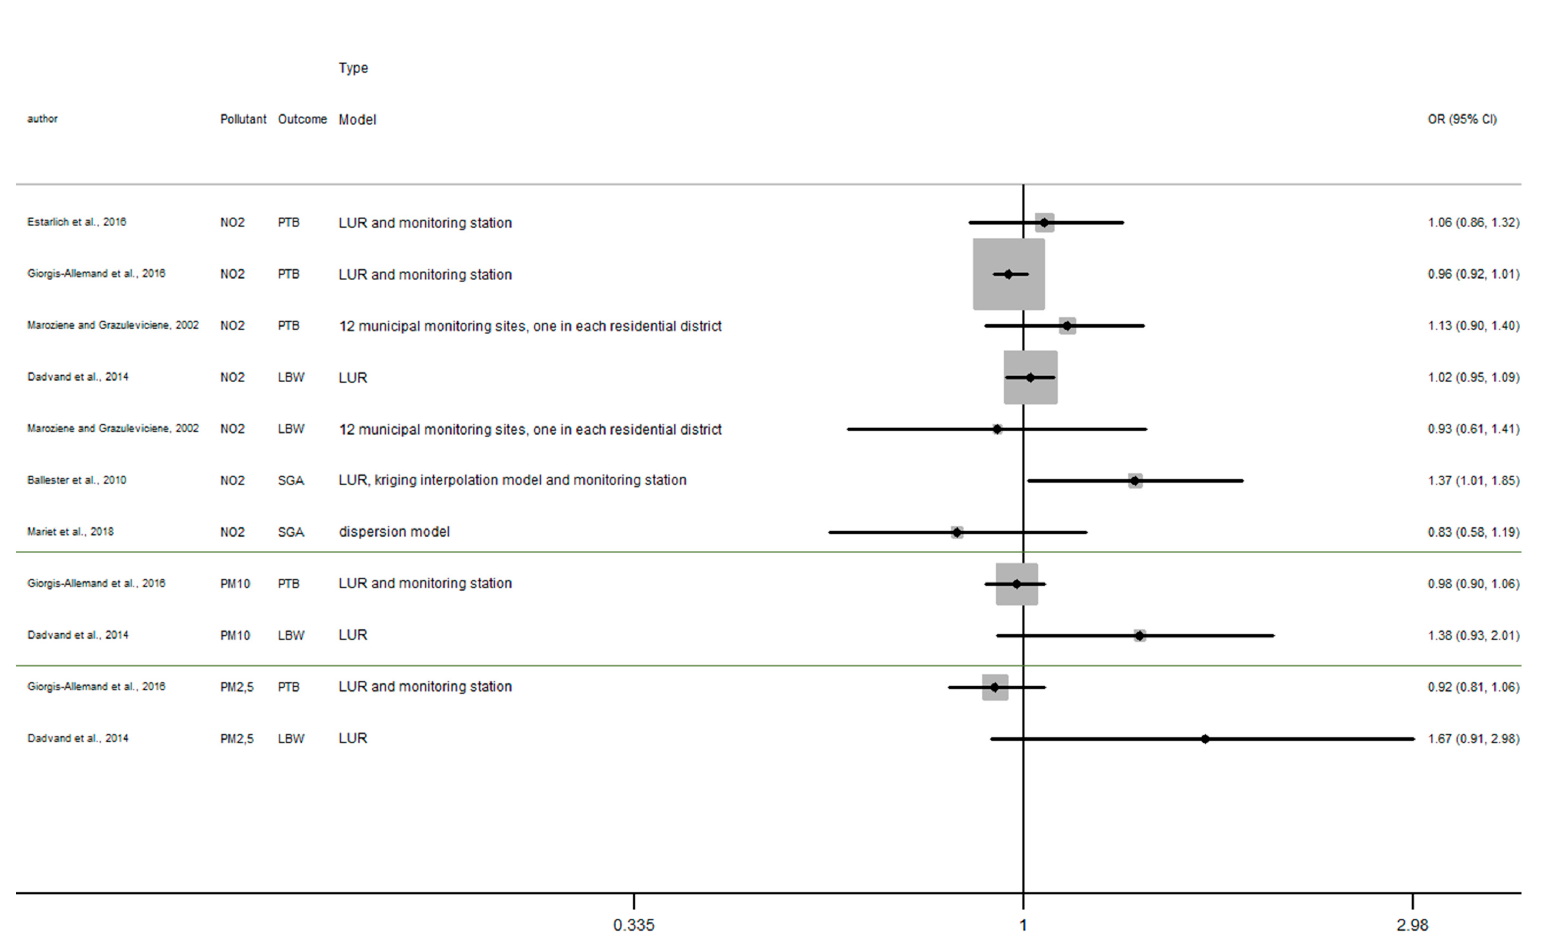
Figure A3. Risk of birth outcome for air pollutant exposure during second trimester.